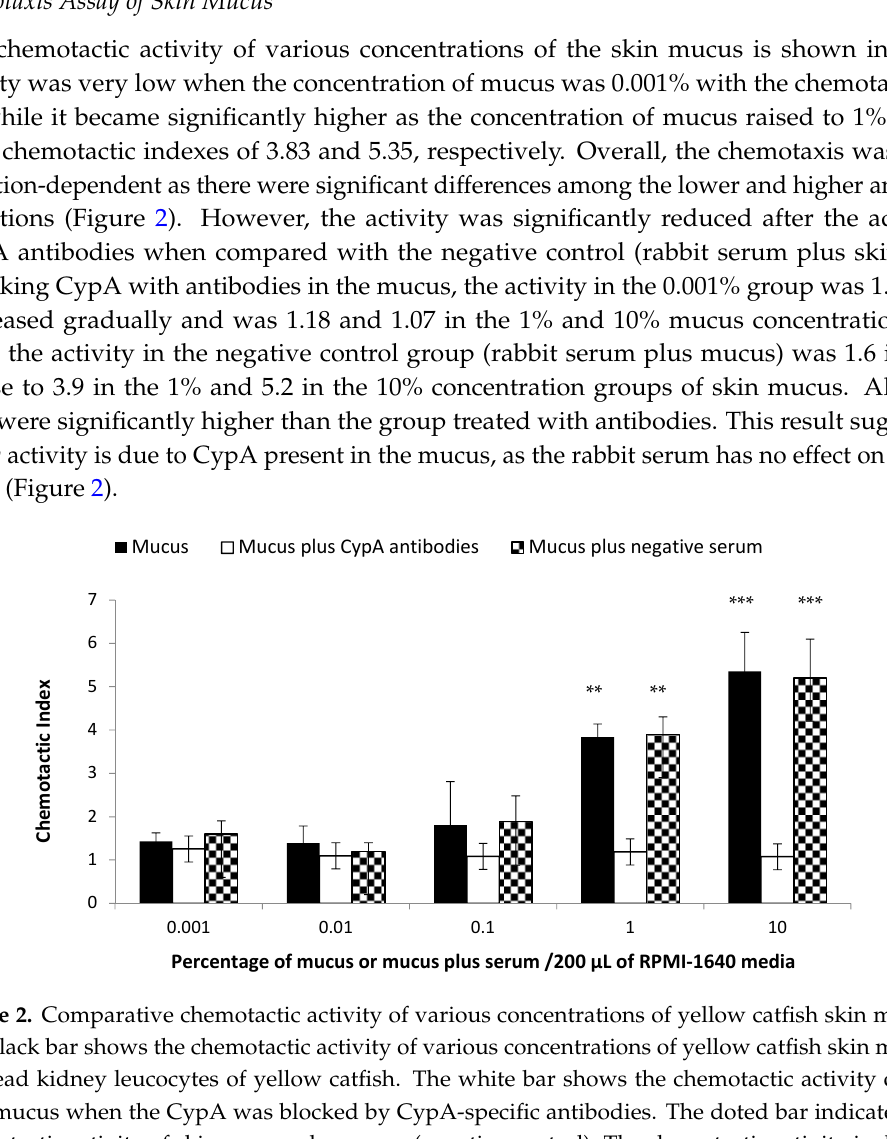
Figure 1. Result of CypA in the skin mucus detected by Western blot. Anti-CypA antibody was used to detect CypA. The CypA band is marked and equal to the precise size (~18 kDa) of the marker.